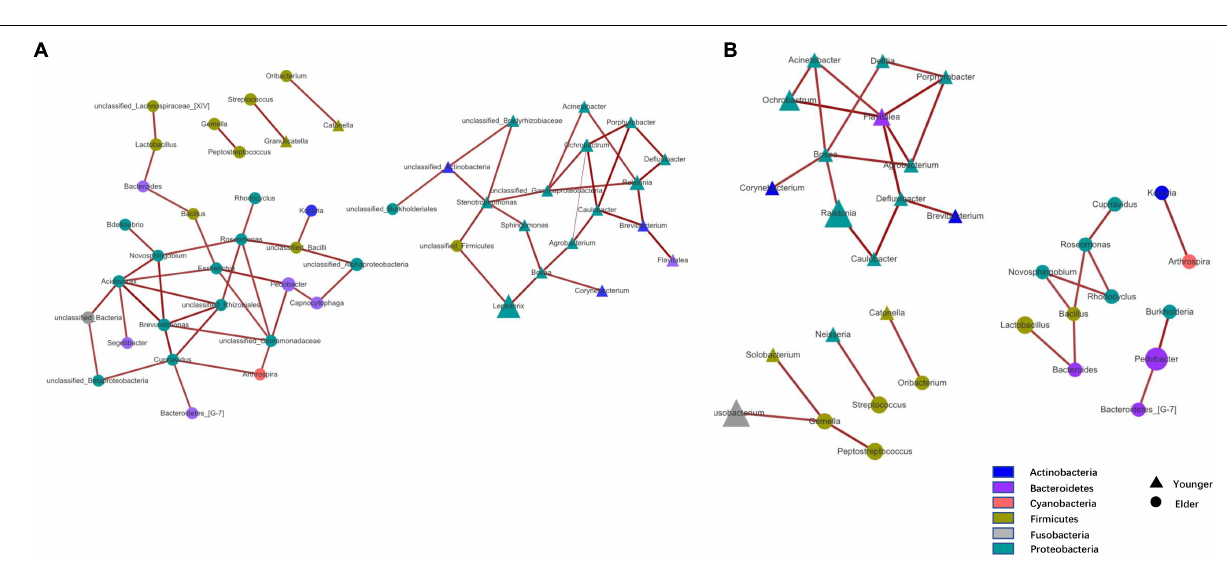
FIGURE 2 | Taxa network based on unfiltered (A) and filtered (B) OTU table. Genera that were more dominant in younger group were represented by triangle and in elder group were represented by circle. Area of the shape means the relative abundance of the genera, weightiness of the line stand for the